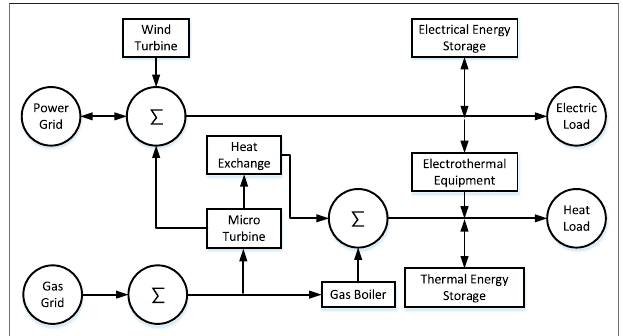
FIGURE 2 | CHP-MG source-side system structure